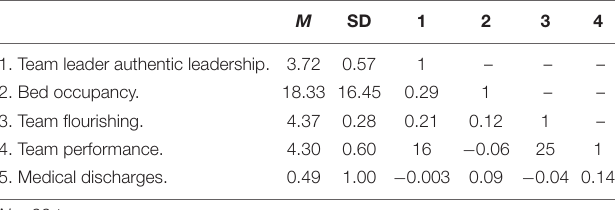
TABLE 1 | Descriptive statistics and correlations.